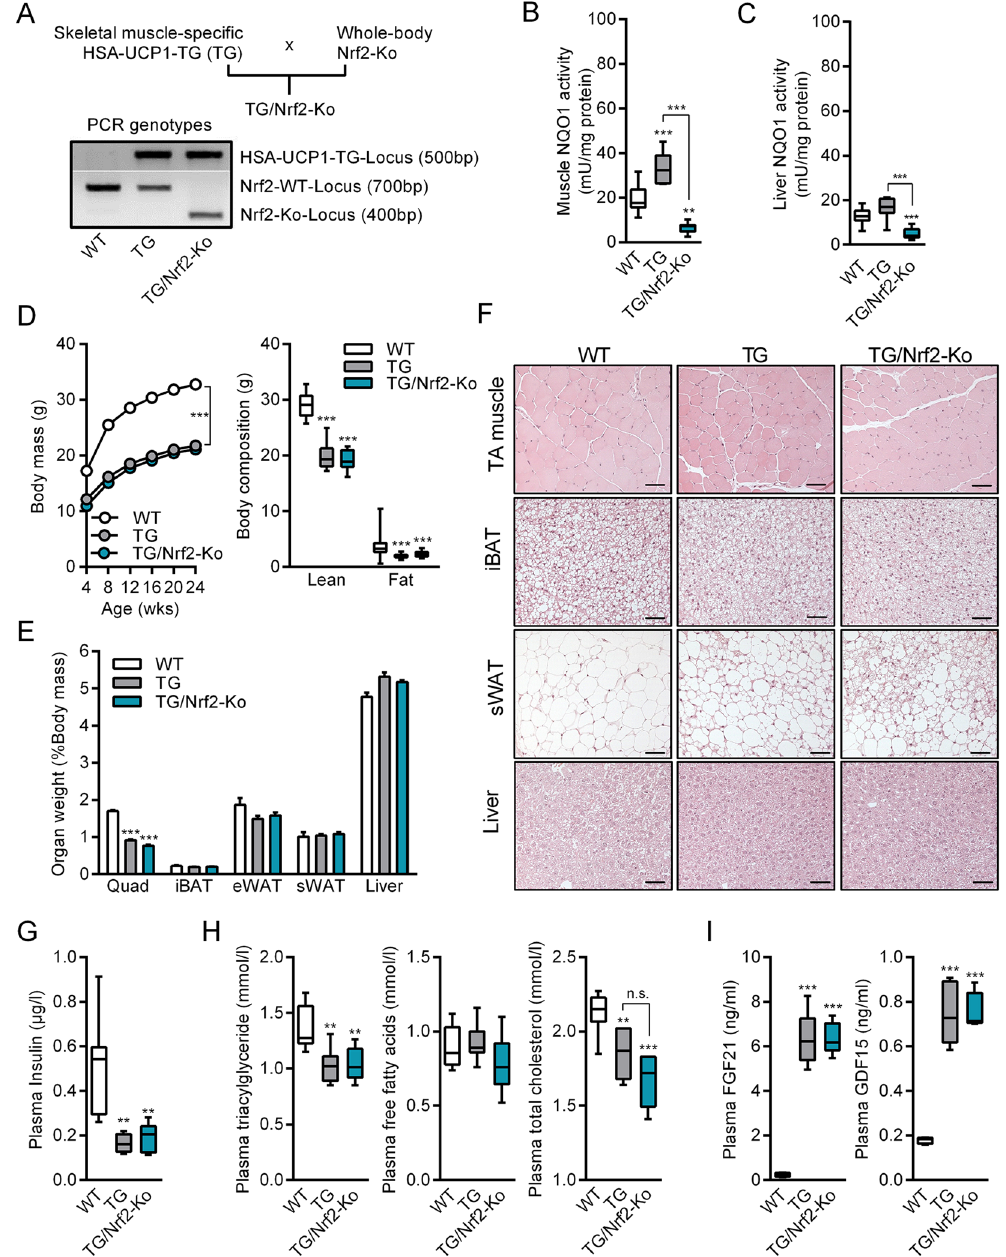
Figure 1. Phenotypic characterization of male TG/Nrf2-Ko animals. ( A ) Scheme of crossbreeding and PCR genotyping of skeletal muscle specific HSA-UCP1-transgenic mice (TG) with whole body Nrf2-Knockout (Nrf2-Ko) mice to generate TG/Nrf2-Ko animals from different gels processed in parallel. ( B ) Quadriceps (Quad) muscle ( C ) liver NAD(P)H quinone dehydrogenase 1 (NQO1) activity as prototypic Nrf2-target and proof of principle for functional ablation of Nrf2 action (n = 7–10). ( D ) Body mass development from 4 to 24 wks and final body composition at 24 wks of age ( E ) Relative Quad, interscapular brown adipose tissue (iBAT), epidydimal (eWAT) and subcutaneous white adipose tissue (sWAT) and liver weights ( F ) Representative H&E histological staining of tibiales anterior (TA) muscle, iBAT, sWAT and liver, bars represent 50 µ m. ( G ) Random fed plasma insulin levels and ( H ) plasma triacylglycerides, free fatty acids and total cholesterol (n = 5–9). ( I ) Circulating plasma levels of FGF21 and GDF15 (n = 4–5). All data from 24 wks old male mice. All absolute values are expressed as box-and-whisker plots, relative or normalized data are expressed as means + SEM; ** p < 0.01; *** p <